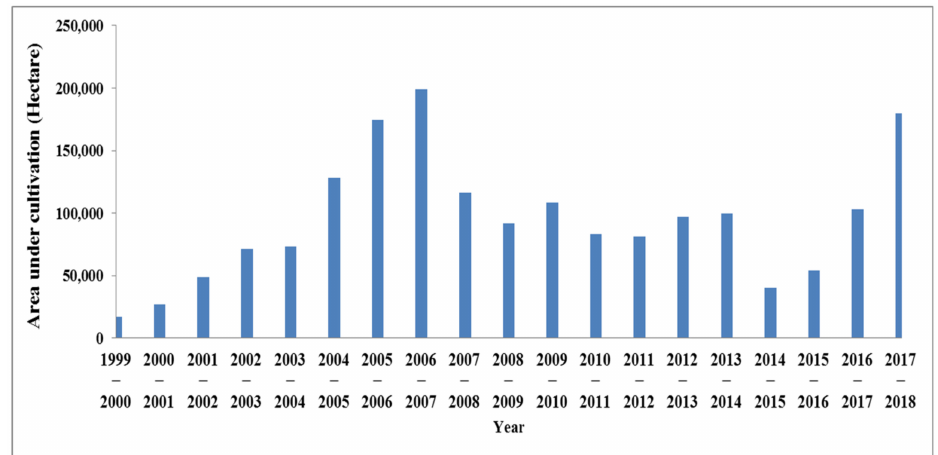
Figure 1. Rapeseed cultivation in Iran over the